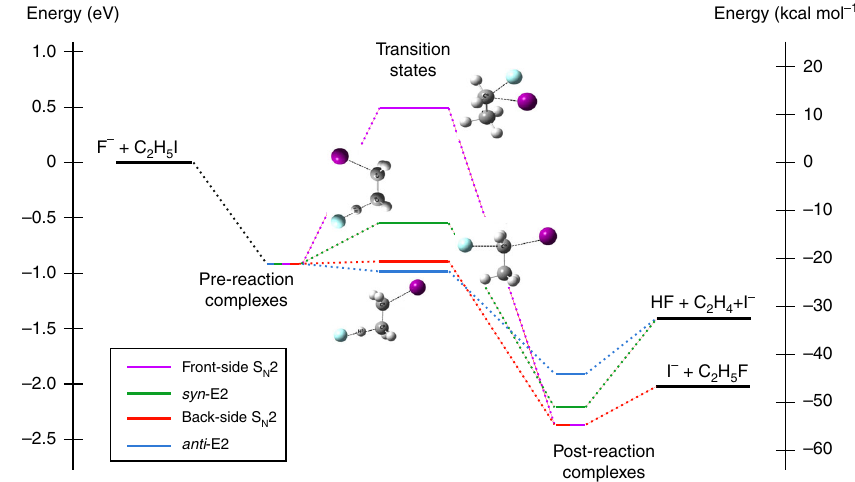
Fig. 3 Schematic representation reaction energy pro fi les for E2 and S N 2 pathways in F − + CH 3 CH 2 I. The calculations have been carried out at the M06/ECP/d level of theory. The optimized TS structures are shown for all four reaction mechanisms. The indicated energies include zero-point